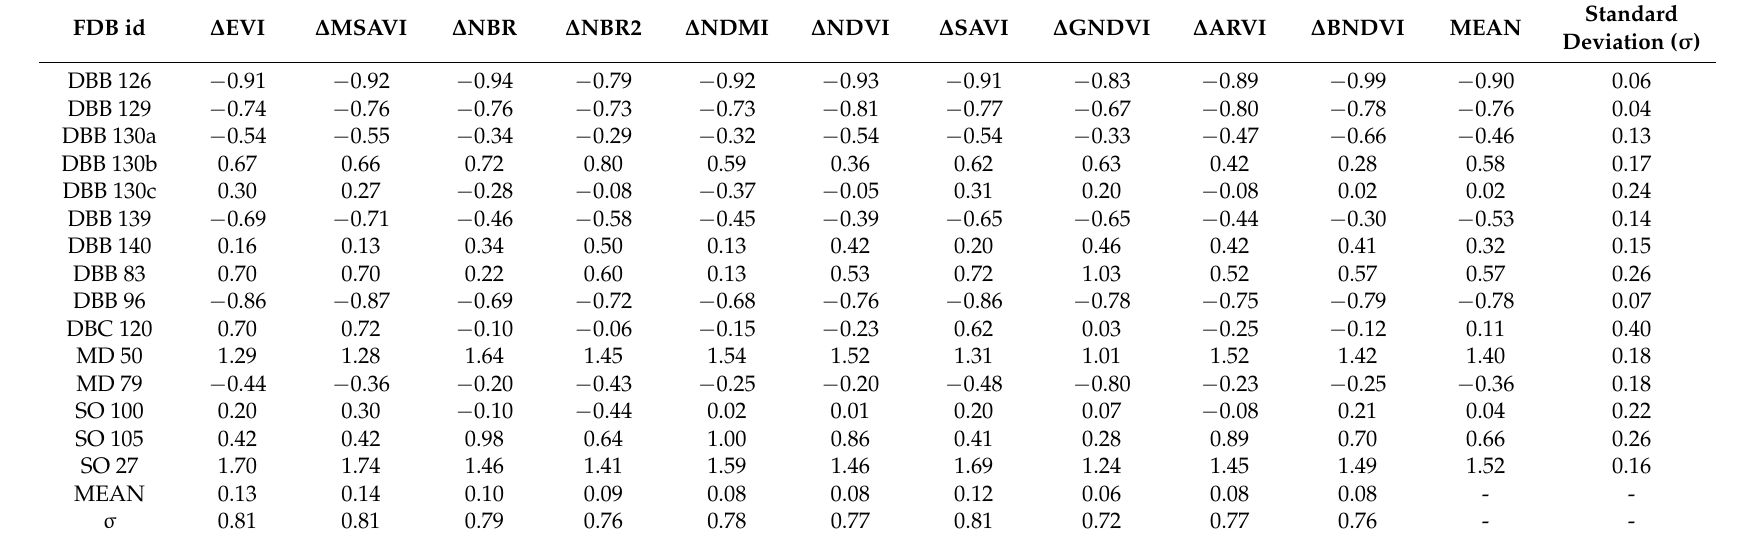
Table 3. Values of differential vegetation indices for each forest